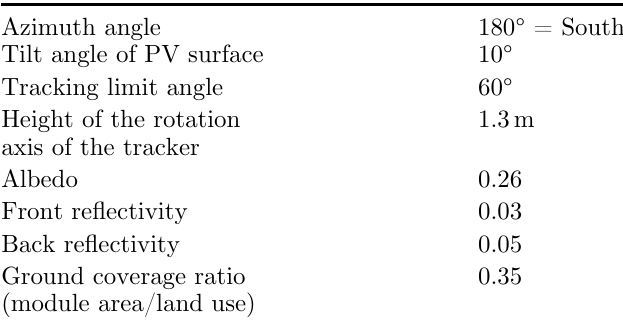
Table 4. Most important simulation parameters for the bifacial PV system